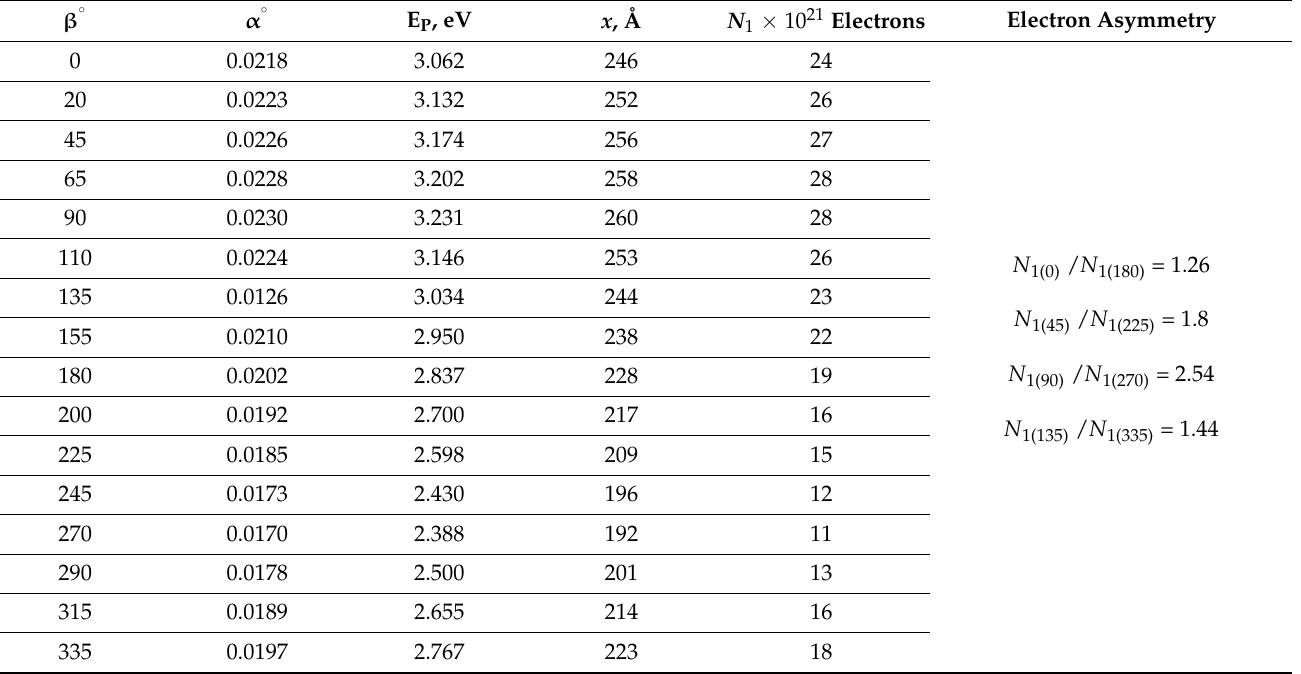
Table 5. Experimental data and results of quantitative calculations of characteristic of surface plas- mons for fused quartz [34].